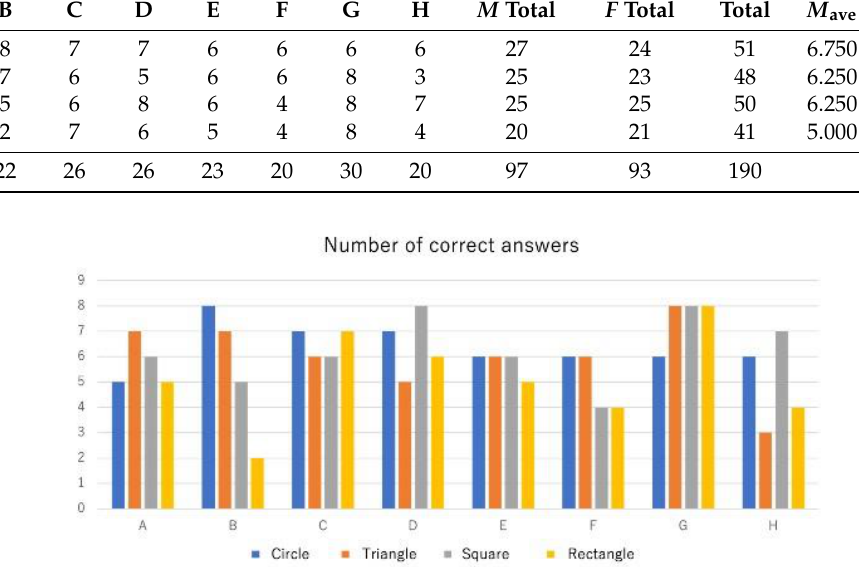
Figure 7. Graphical representation of the distribution of correct answers. Table 3. Statistical analysis results showing that no significant difference exists between the two actuator shapes that had a large difference in terms of the number of correct answers.